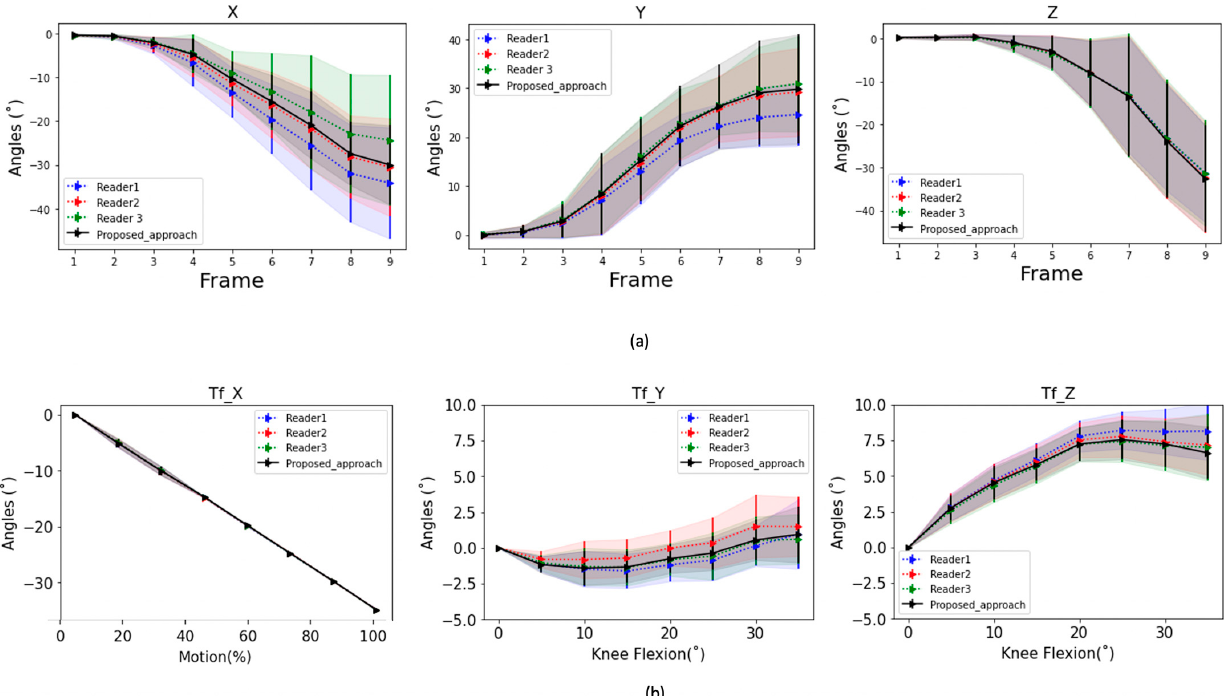
Figure 7. ( a ) 1st Metacarpal bone motion (cardan angles) showing an opposition movement of the thumb from neutral to full opposition. The plots show results using the proposed approach compared to using manual landmarks identified by three readers. X represents the Flexion ( − )/Extension (+) axis, Y is the Adduction ( − )/Abduction (+) and Z represents the Internal (+)/External ( − ) rotation axis; ( b ) Tibiofemoral (Tf) joint motion (cardan angles) obtained in leave-one-out valida- tion on 10 subjects for the first 30° of knee flexion. The plots show results using the proposed approach compared to using manual landmarks identified by the three readers. Shaded regions represent 95% Confidence Interval over all subjects. ( a ) Tf_X represents the Flexion ( − )/Extension (+) axis, Tf_Y represents Adduction ( − )/Abduction (+) axis and TF_Z represents Internal (+)/External ( − ) rotation axis.